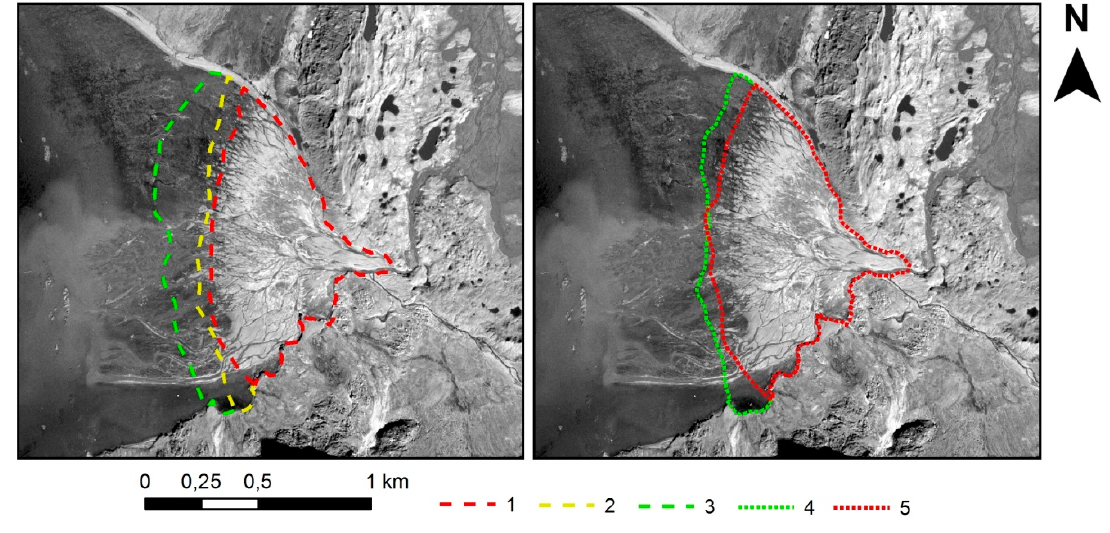
Figure 7. Evolution of the Nottingham outwash fan averaged over periods: (1) range in 1985–2000, (2) range in 2000–2010, (3) range in 2010–2017, (4) low tides (0.4–0.4 m), and (5) high tides (1.2–1.3